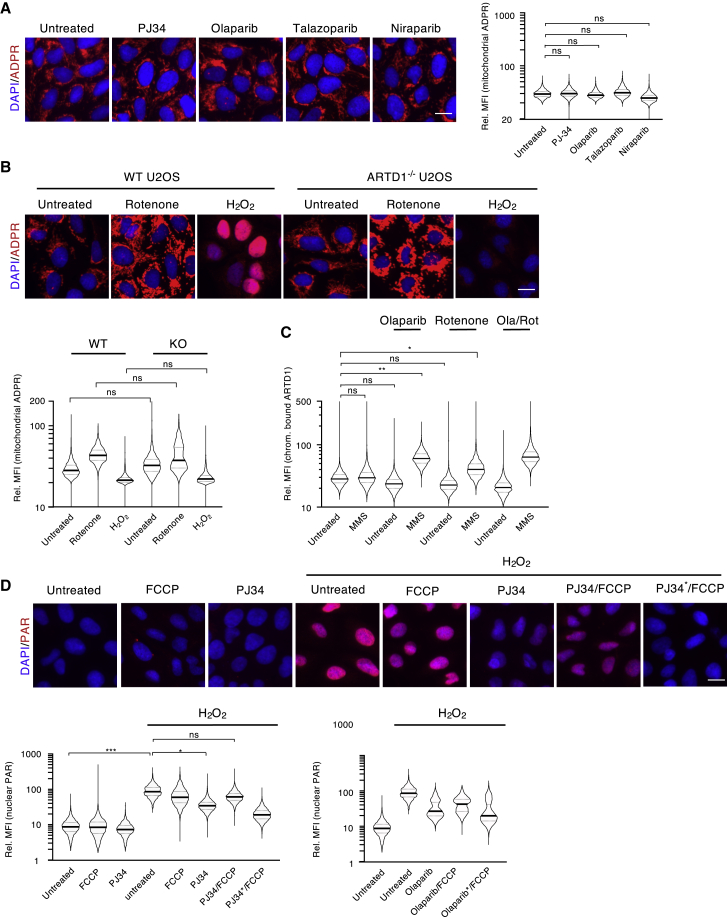
Release of Mitochondrial NAD+ Antagonizes PARP Inhibitor Treatment(A) U2OS cells were treated with PJ34, olaparib, talazoparib, or niraparib, and mitochondrial ADP-ribosylation was subsequently assessed via IF using the anti-ADPr antibody.(B) U2OS ARTD1−/− cells were treated with either rotenone or H2O2, and the mitochondrial and nuclear ADP-ribosylation were assessed via IF with our anti-ADPr antibody.(C) U2OS cells were co-treated with MMS and olaparib, rotenone or a combination for 2 h and after pre-extraction, chromatin-bound ARTD1 was analyzed via IF.(D) U2OS cells were pre-treated with PJ34 or olaparib, then subjected to an FCCP pulse followed by H2O2 and analyzed via IF using an anti-PAR antibody. ∗ = 5-fold increased concentration of inhibitors. Representative pictures are shown in the upper panel; the quantification of the nuclear PAR signal is shown in the lower panel. The quantifications of all signals (mitochondrial and nuclear) were normalized as described in Figure 1, and the y axes of all plots are depicted as log10 scale. Scale bars indicate 20 μm.